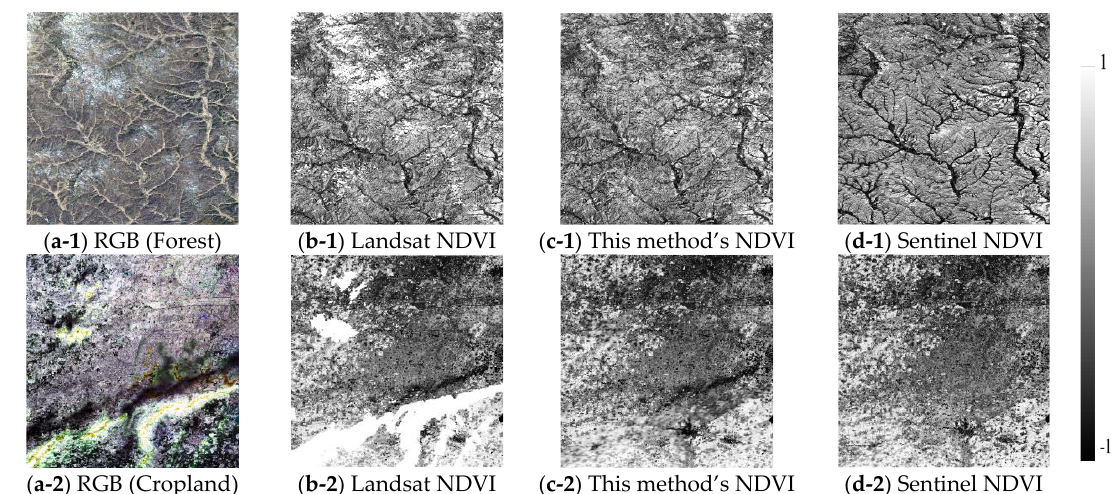
Figure 6. Validation of random point and true-color image distribution and comparison of the mean NDVI statistical analysis for the method in this paper and Sentinel. ( a ) Validation of random point and true-color image distribution. ( b ) Change in the mean value of NDVI. ( c ) Comparison of this paper's method with Sentinel NDVI for different vegetation types.